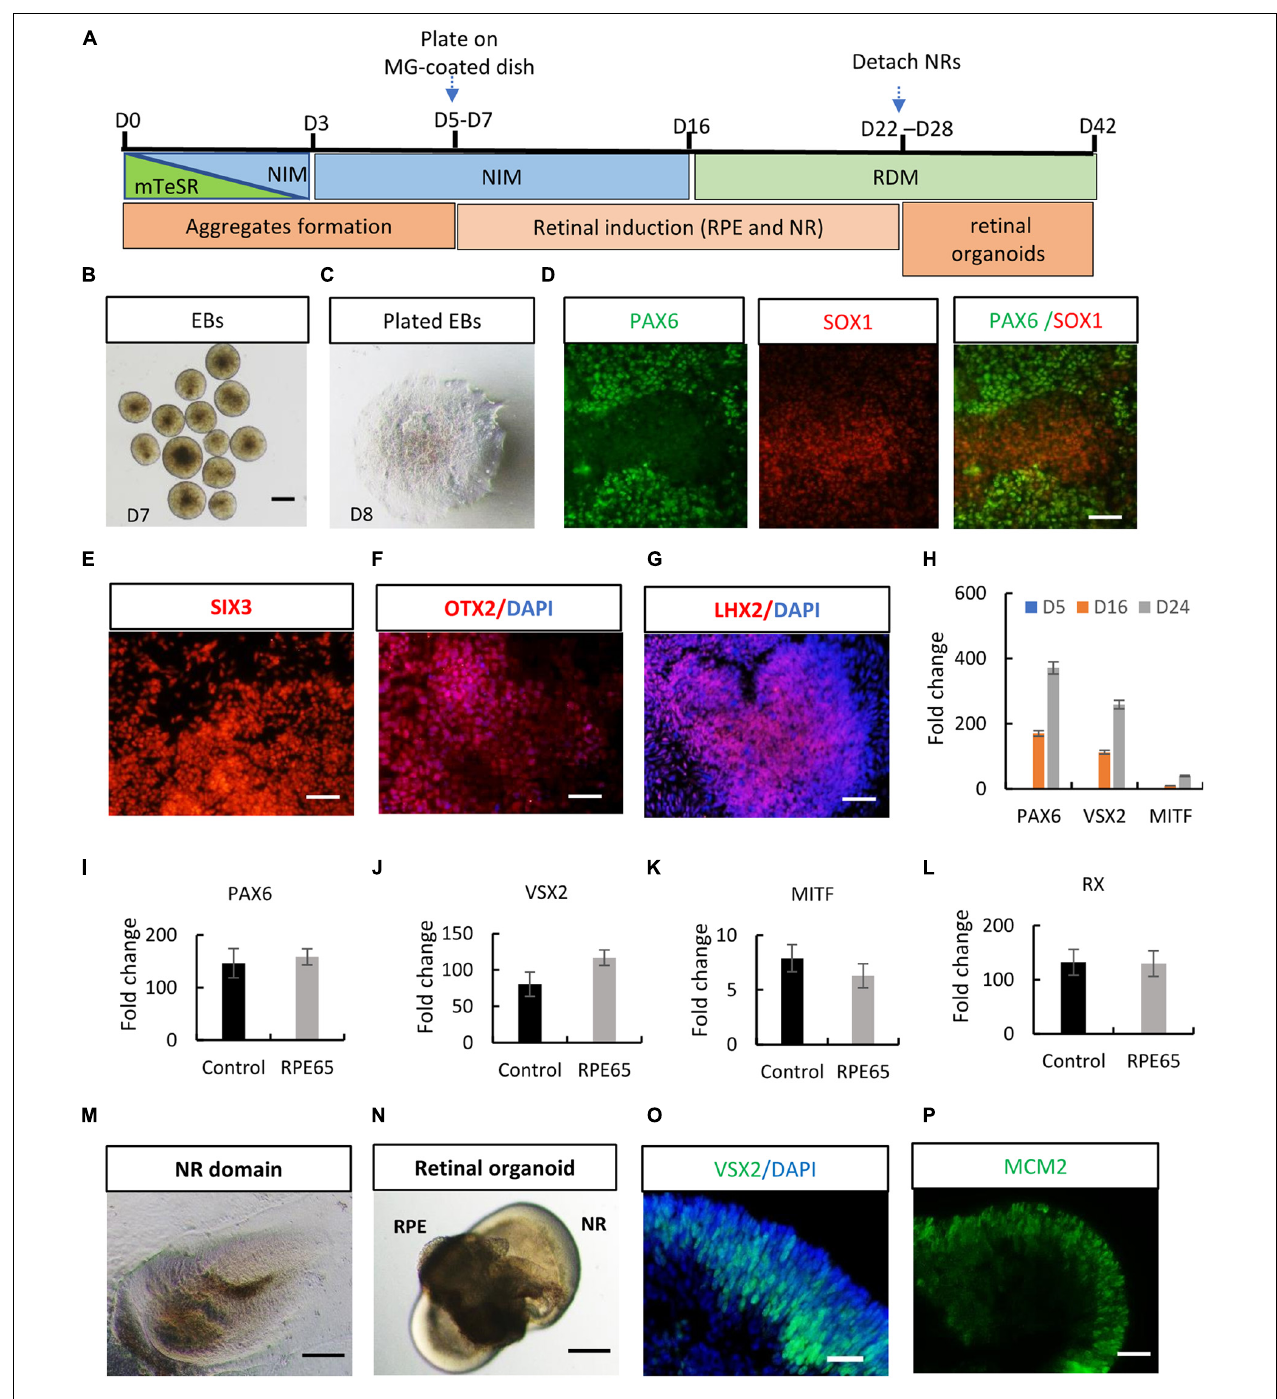
FIGURE 3 | Acquisition of retinal organoids and RPE cells from RPE65-hiPSCs. (A) Schematic overview of retinal differentiation protocol. (B) Floating embryoid bodies (EBs). (C) EBs plated on Matrigel-coated dishes on D7. Scale bars, 200 µ m. (D) The adherent EBs acquired an anterior neuroepithelial fate characterized by PAX6 and SOX1 expression. Scale bar, 50 µ m. (E–G) SIX3, OTX2, and LHX2-positive retinal progenitor cells appeared around D12. Scale bars, 20 µ m. (H) qRT-PCR showed progressive increase of expression level of retinal progenitor markers PAX6 and VSX2 and RPE marker MITF during retinogenesis of RPE65-hiPSCs. RPE65-hiPSCs derived EBs (D5) as reference. Mean ± SD , n = 3. (I–L) Comparison of mRNA expression level of retinal progenitor markers (PAX6, VSX2, and RX) and RPE marker (MITF) between control and RPE65 hiPSCs on D16 after retinal differentiation. Control hiPSCs derived EBs (D5) as reference. No significant difference was disclosed between them ( P > 0.05), mean ± SD , n = 3. (M) Typical morphology of horseshoe-like NR domains. Scale bar, 200 µ m. (N) Representative image of retinal organoids containing NR and RPE. Scale bar, 200 µ m. (O,P) Immunofluorescence staining showed retinal progenitor cells expressing VSX2 and MCM2 occupied the whole neural retina on D35 after differentiation. Scale bars, 20 µ m.